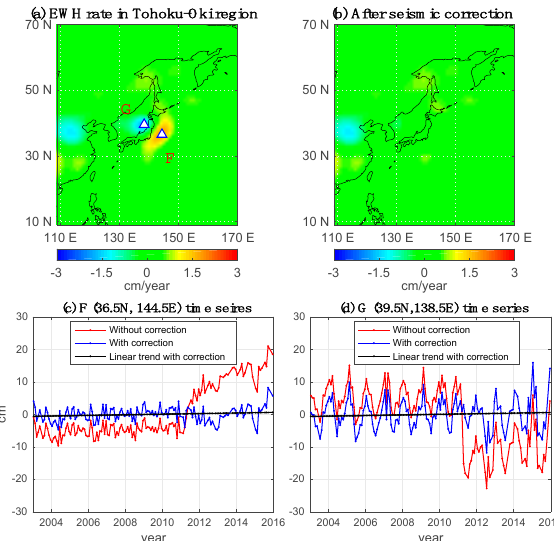
Figure 4. ( a ) The EWH rate distribution in the Tohoku-Oki earthquake region, ( b ) the rate distribution after the seismic effect correction, ( c ) the time series at the point F (36.5°N, 144.5°E), and ( d ) the time series at the point G (39.5°N, 138.5°E).